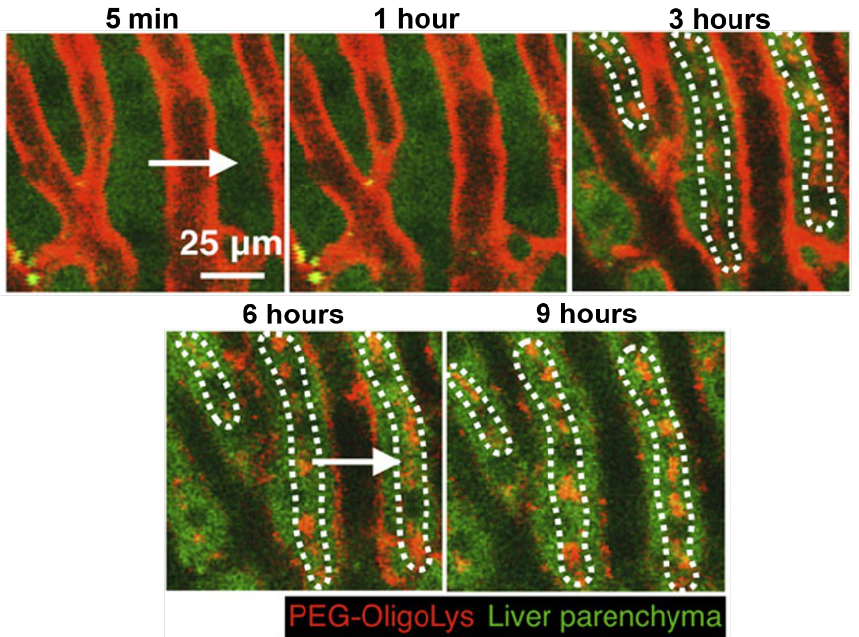
Figure 8. Schematic representation of the interaction of poly(ethylene glycol)-two-arm-PEG-oligo (L-lysine) with liver sinusoidal wall and biliary excretion using IVRT-CLSM with real-time imaging at multiple time intervals of 5 min, 1 h, 3 h, 6 h, and 9 h. Adapted with permission from [53].